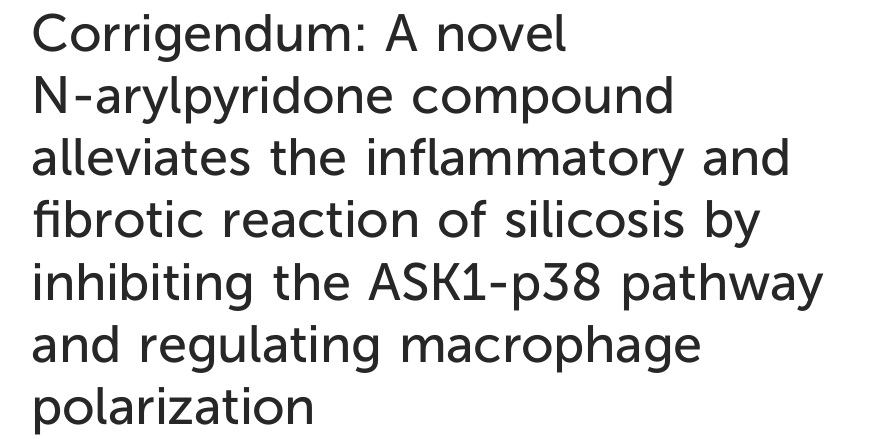
AKEX0011 inhibited RAW264.7 from secreting pro-in fl ammatory cytokines, blocked p38 MAPK signaling, and reduced silica-induced apoptosis and M1 polarization. There were eight cell groups: PBS Control (abbreviated as “ Control ” in the graphs), PBS + AKEX0011 (200 μ g/ml) (abbreviated as “ AKEX ” ), Silica pre, Silica pre + AKEX0011 (100 μ g/ml) (abbreviated as “ Si pre + AKEX L ” ), and Silica pre + AKEX0011 (200 μ g/ml) (abbreviated as “ Si pre + AKEX H ” ), Silica